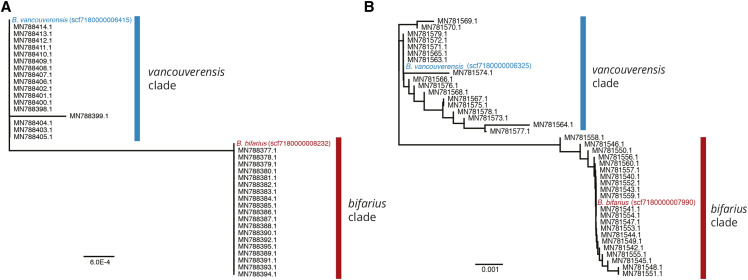
Confirming sample identity for the B. bifarius and B. vancouverensis genomes. A-B) Neighbor joining distance trees for the A) serrate RNA effector and B) sodium/potassium transporting ATPase subunit alpha genes from Bombus bifarius and Bombus vancouverensis assemblies aligned to GenBank accessions (tip labels on tree) originally used for delimitation of these sister species (from NCBI PopSet 1803131478 and 1803131398; Ghisbain et al. 2020).